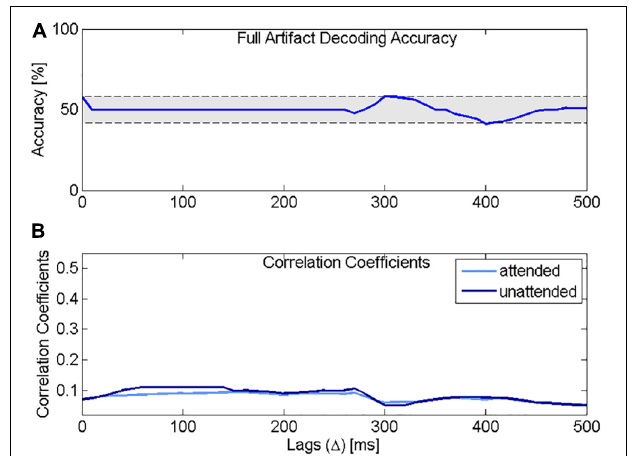
FIGURE 5 | Decoding accuracy and correlation coefficients using the physical model. (A) Selective attention accuracy using the attended decoder, trained with a simulated EEG signal containing only artifact. (B) Correlation coefficients for the attended speech (light blue) and the unattended speech (dark blue) using the attended decoder trained with simulated EEG data containing only artifact. The correlation coefficients for the attended and the unattended speech sounds overlap and drop rapidly with increasing